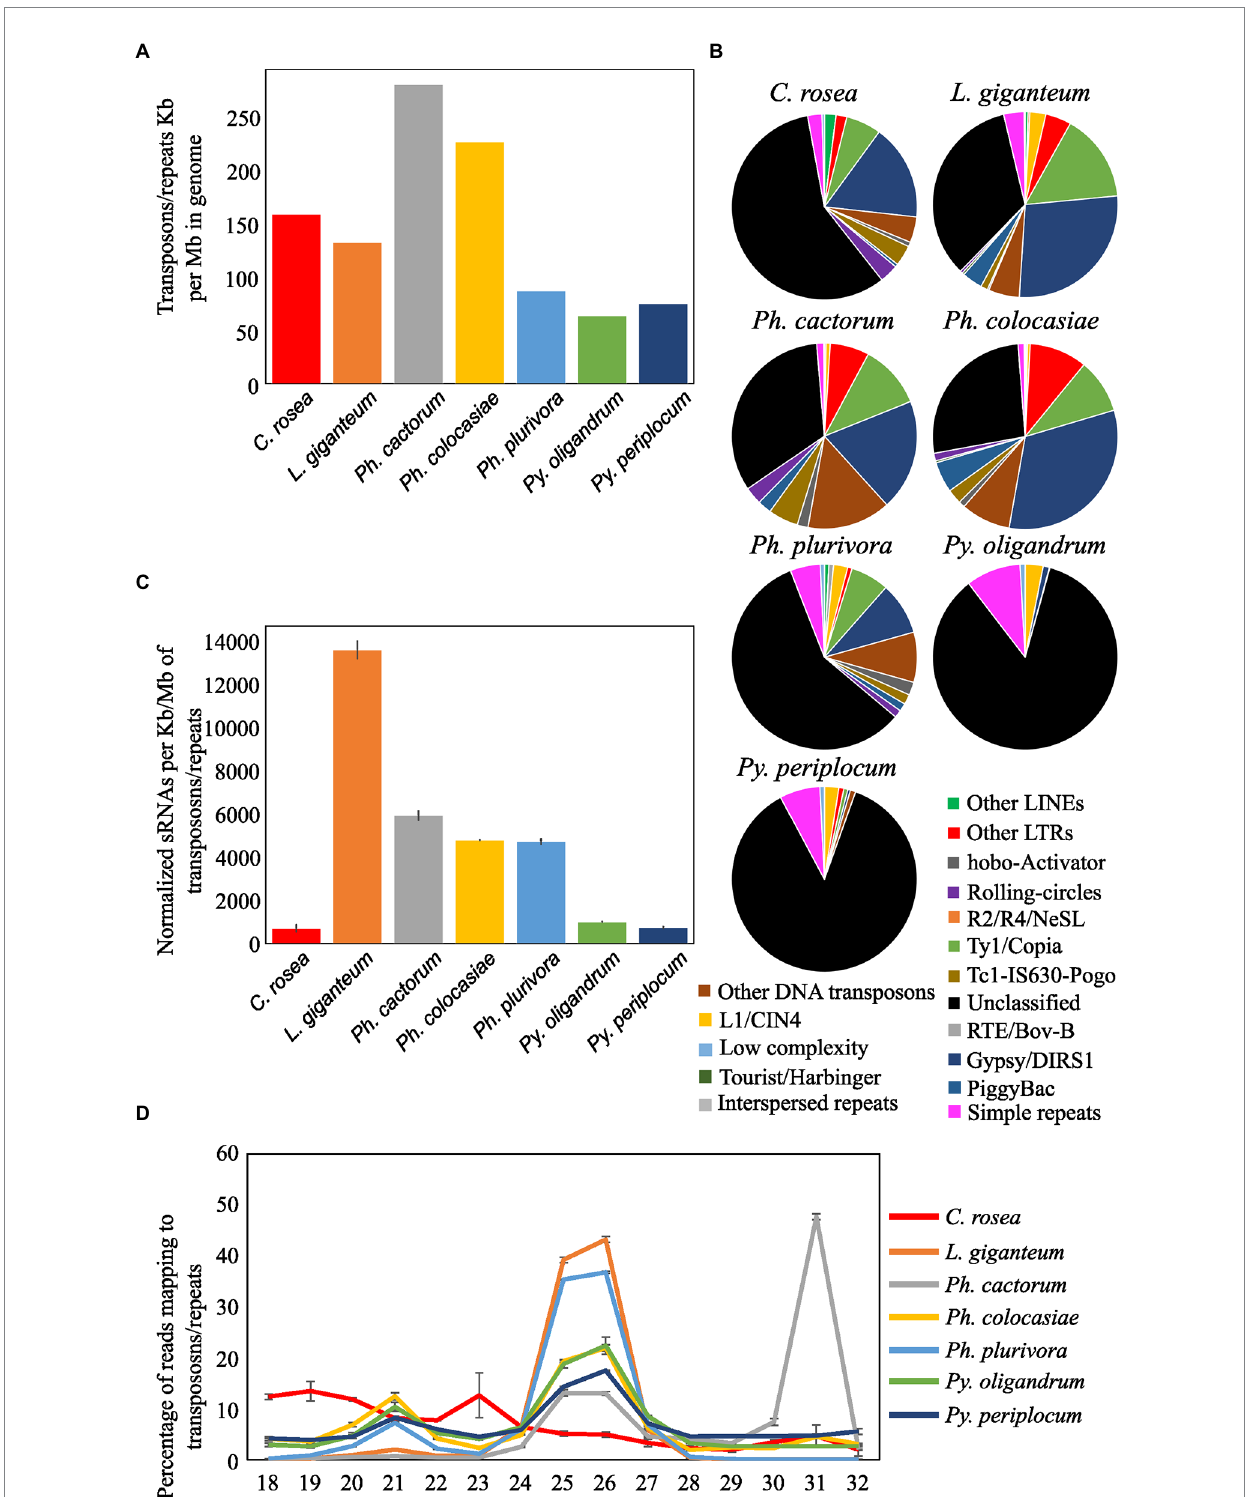
FIGURE 7 Identification of transposons and repeated sequences with RepeatModeler. (A) Extent of transposons and repeated sequences in the analyzed species. (B) Families of transposons identified in the genomes of the species of interest. (C) Number of sRNA reads mapping to transposons and repeated sequences. Data normalized according to millions of reads per sample, length of the genomes and length of the repetitive regions. Error bars indicate the standard deviation. (D) Length distribution of sRNA mapping to transposons and repeated